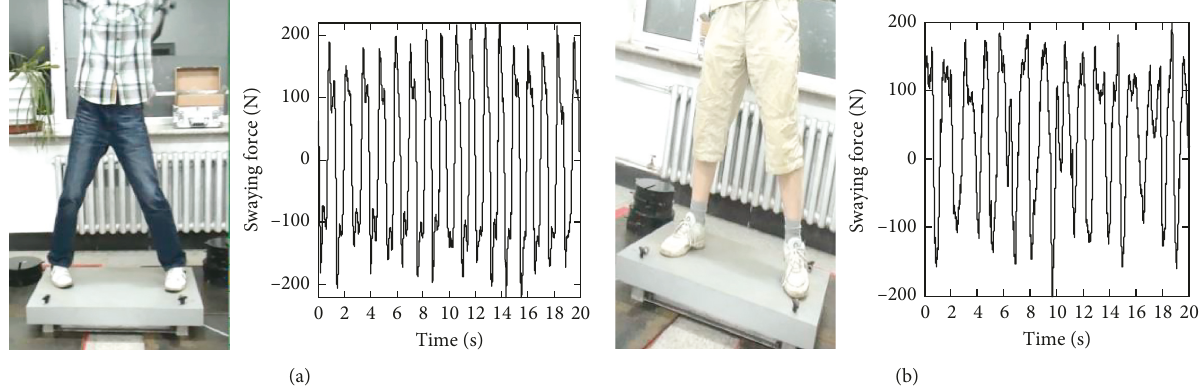
Figure 2: Swaying test and load curve. (a) 2nd participant swaying. (b) 3rd participant